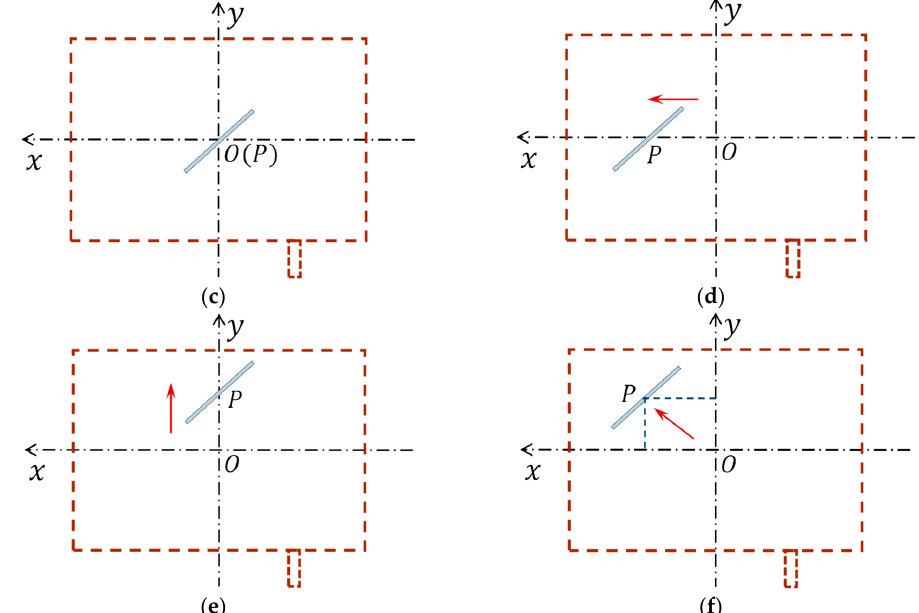
Figure 4. Simulation model. ( a ) entire model in HFSS TM ; ( b ) quantitative description of the crack; ( c ) cracks located at the center of the ground plane; ( d ) crack position moving leftwards; ( e ) crack position moving upwards; ( f ) crack position moving leftwards and upwards simultaneously.